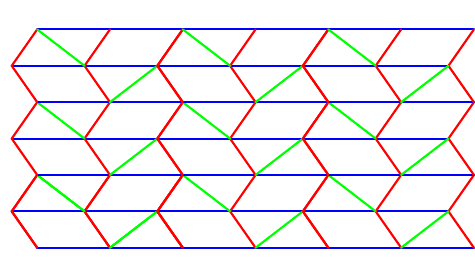
Fig. 23: Tiling with two equal (non- consecutive) parallelograms and three equal tri- angles.